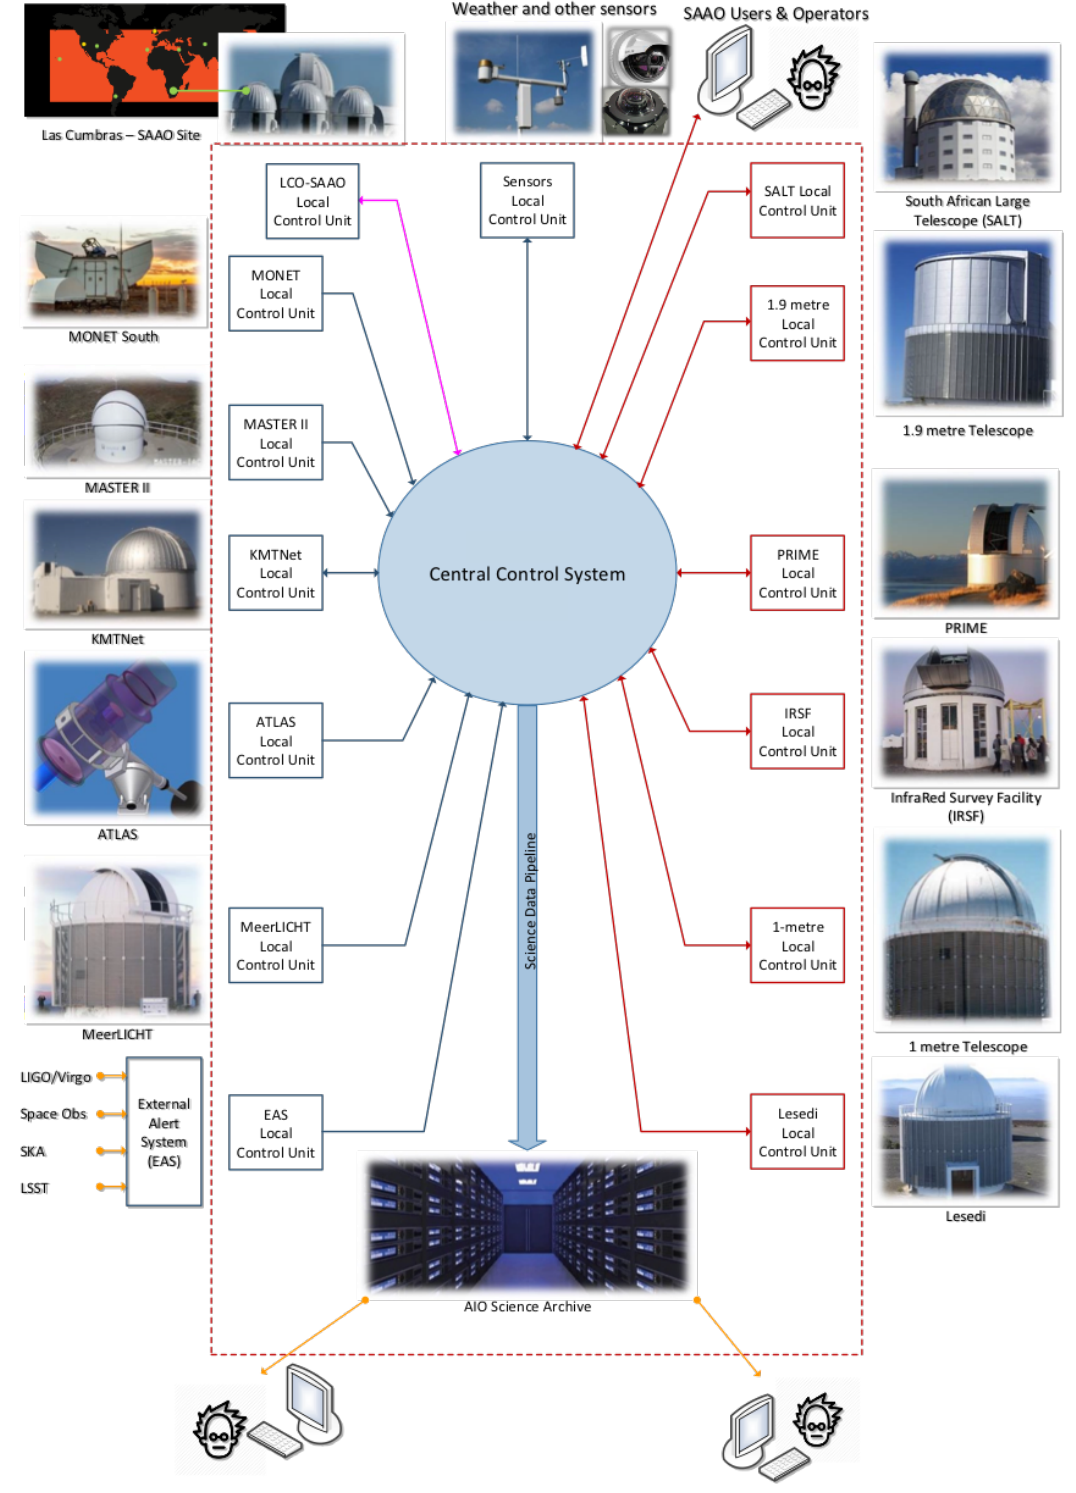
Figure 2. Intelligent Observatory